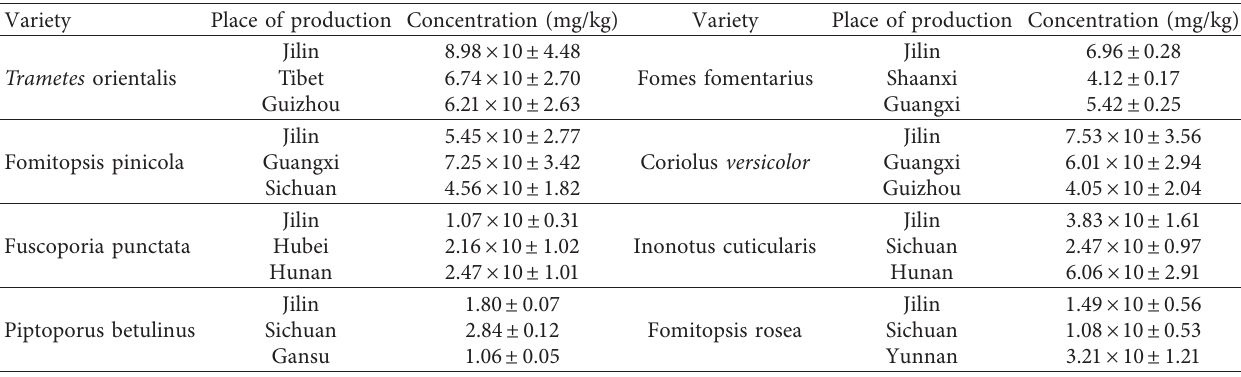
Table 6: Determination results of ganoderic acid A content in dried G. lucidum analogues from different varieties and sources. Variety Place of production Concentration (mg/kg) Variety Place of production Concentration (mg/kg) Trametes